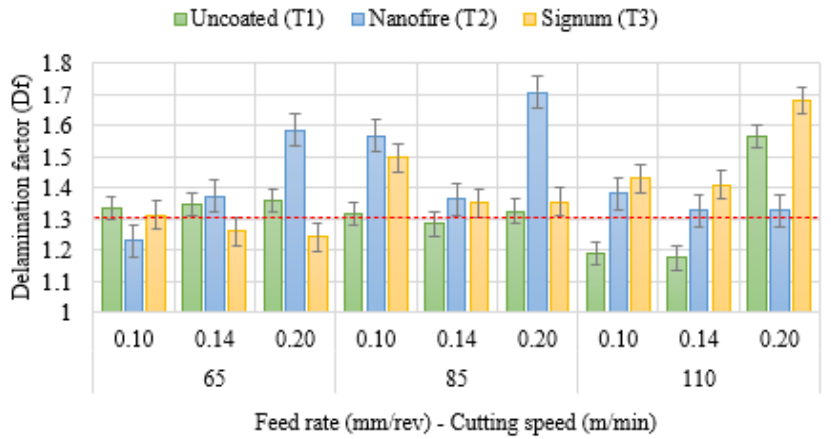
Figure 9. Effect of drilling parameters and coating properties on the delamination factor